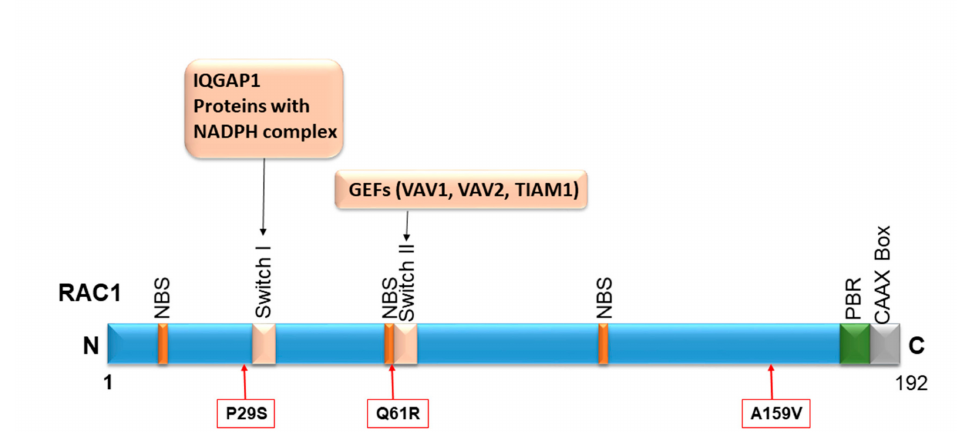
Figure 1. Schematic diagram of the domain structure of RAC1: Di ff erent domains of RAC1 include Nucleotide Binding Sites (NBS), switch I, switch II, Poly-Basic Region (PBR), and the CAAX box. The most important missense mutations in the context of oncogenic transformation are presented in the box, and the positions are indicated with arrows. Switch I primarily interacts with downstream e ff ectors of RAC1, e.g., IQGAP1 and proteins in the NADPH complex. Switch II interacts with the RAC1-activating protein, guanine nucleotide exchange factors (GEFs). Switch II is the site where RAC1 becomes activated in its GTP-bound state. The diagram shows where e ff ectors bind and where GEF proteins bind in switch I and II